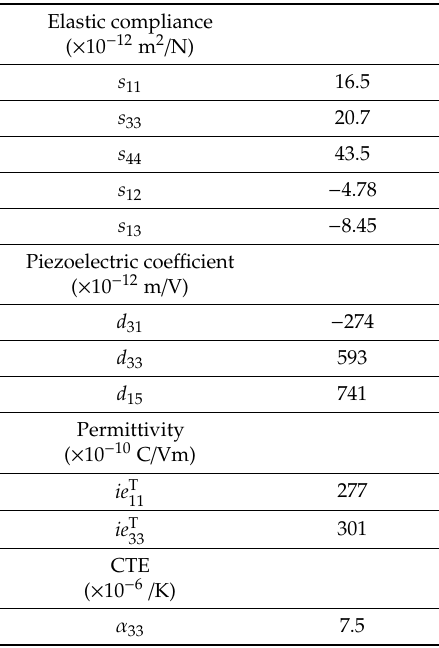
Table 1. Material properties of PZT.